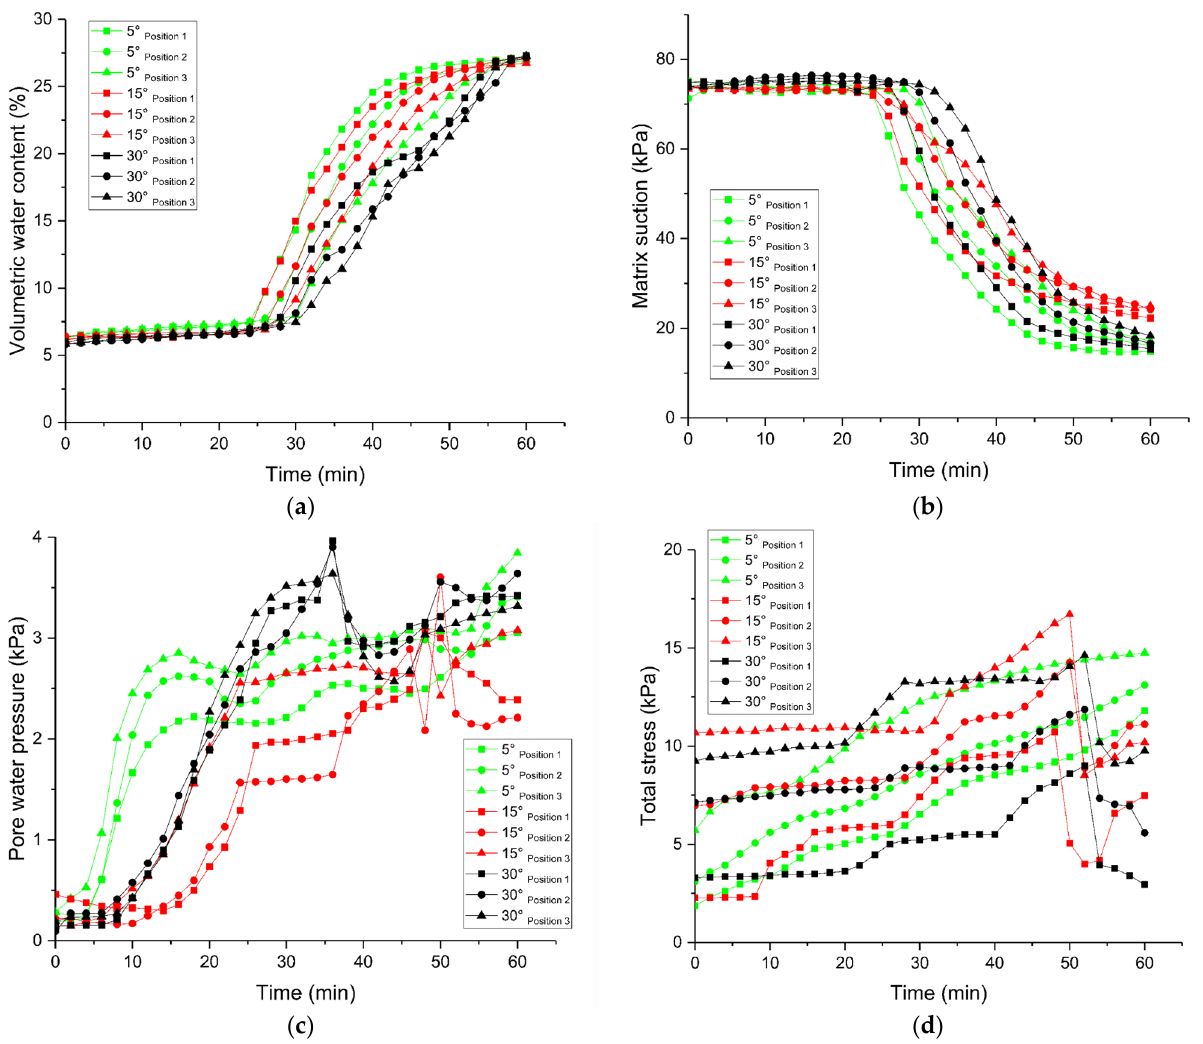
Figure 8. Variation in measured data when slope gradients are different: ( a ) water content; ( b ) matrix suction; ( c ) pore water pressure; ( d ) total stress.